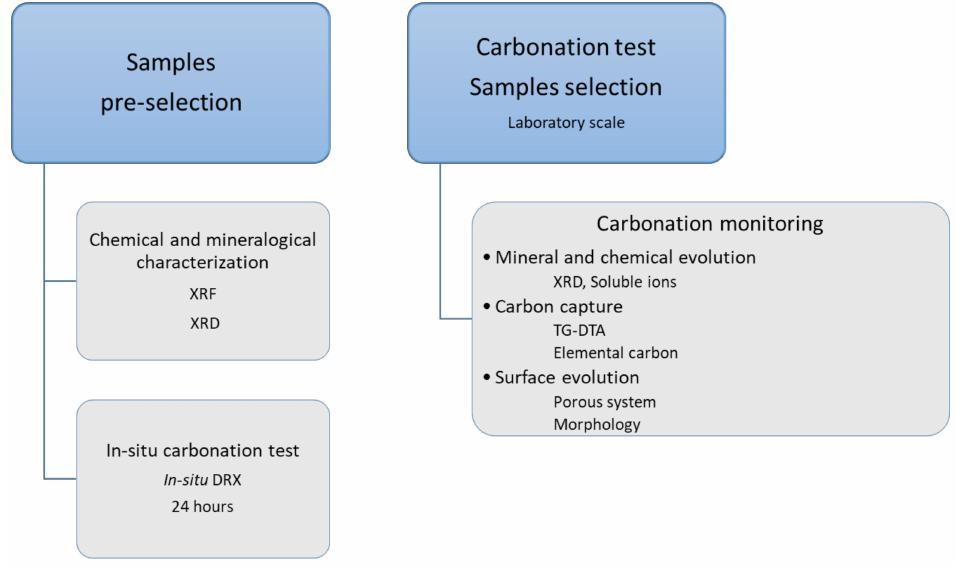
Figure 1. Flow diagram of proposed